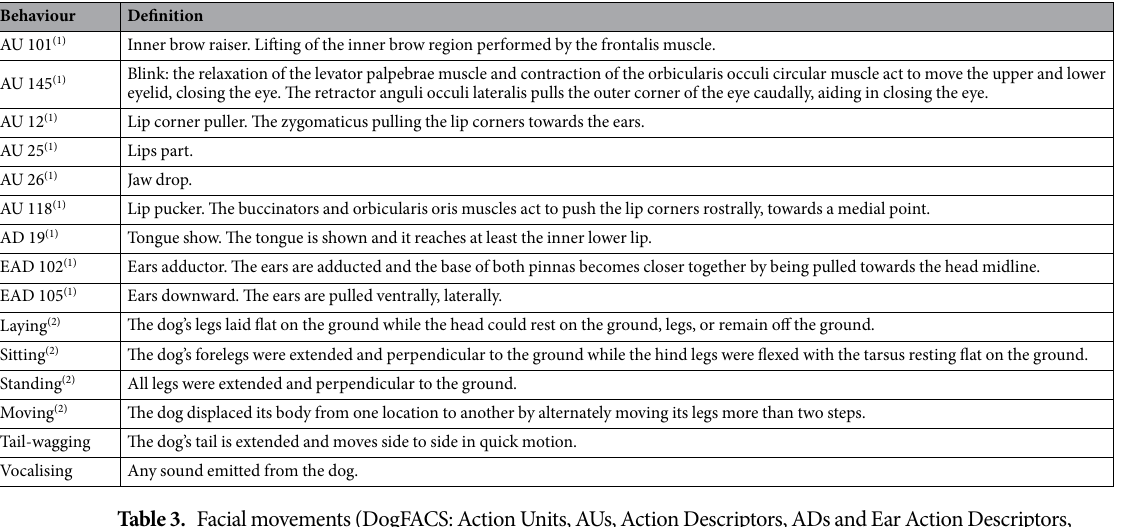
Table 3. Facial movements (DogFACS: Action Units, AUs, Action Descriptors, ADs and Ear Action Descriptors, EADs) and general behaviours coded. Listed definitions were partly obtained from (1) Waller et al . 2013 and (2) Call et al .